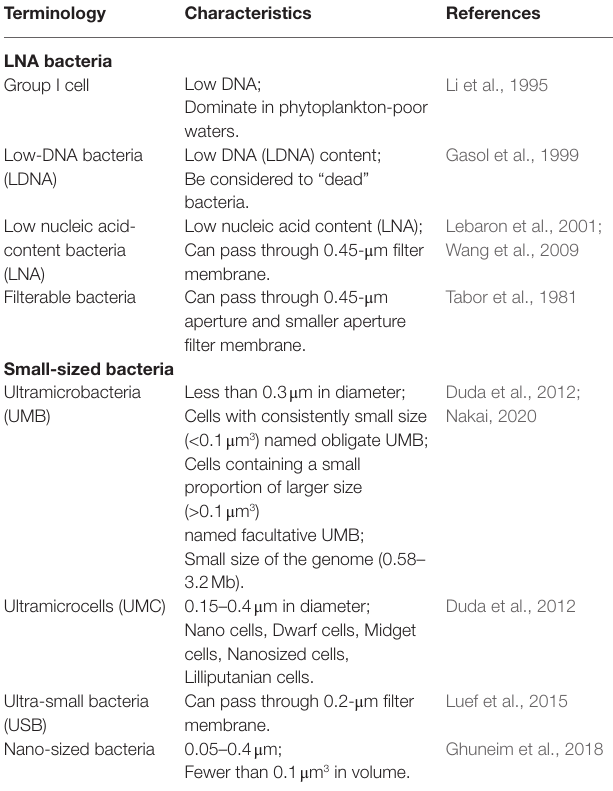
TABLE 1 | Description of terms relating to LNA and small-sized